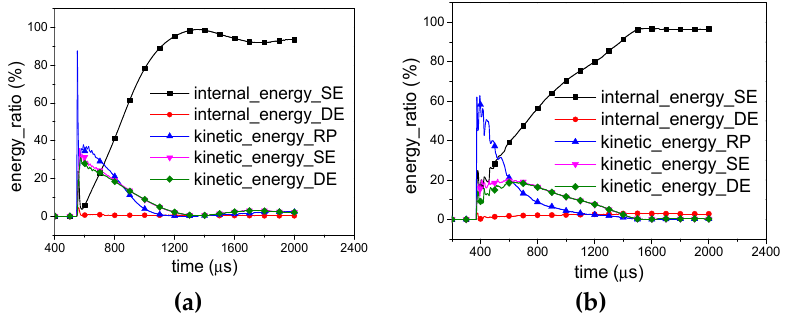
Figure 10. Energy distribution in X1 -RP-H-RP. ( a ) Overall response mode; ( b ) Transitional response mode; ( c ) Local response mode.